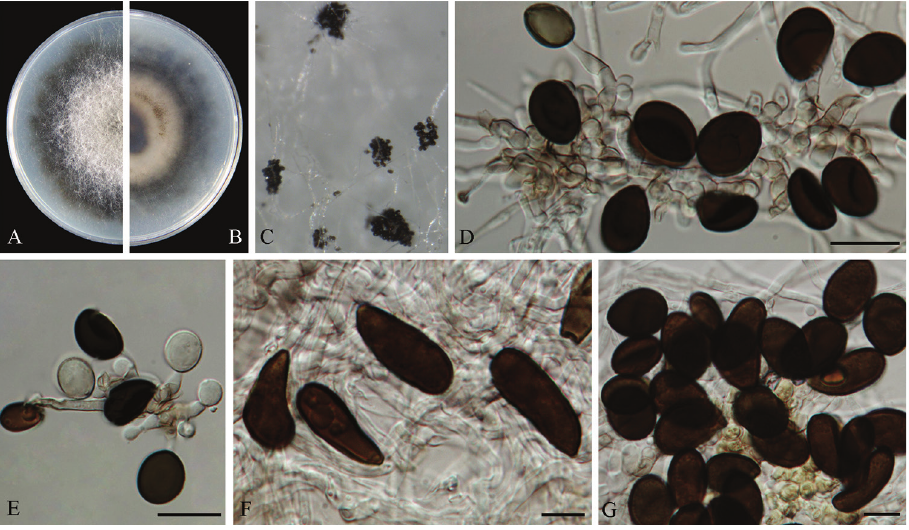
Figure 8. Arthrinium obovatum (from ex-holotype strain CGMCC 3.18331) A–B 7 d old cultures on PDA C Colony on MEA producing conidia masses D–E Conidiogenous cells giving rise to conidia F Obovoid conidia G Globose to subglobose conidia. Scale bars = 10